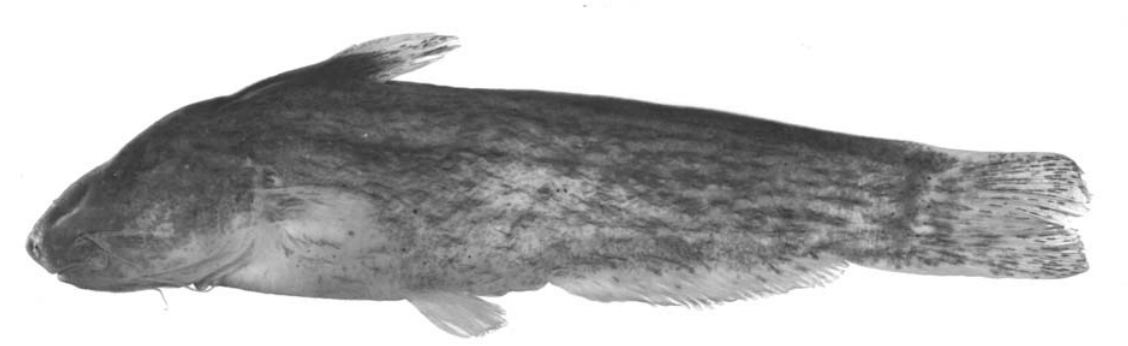
Fig. 47. Denticetopsis iwokrama , new species, holotype, ANSP 177215, 43 mm SL; Guyana, Essequibo, Siparuni River